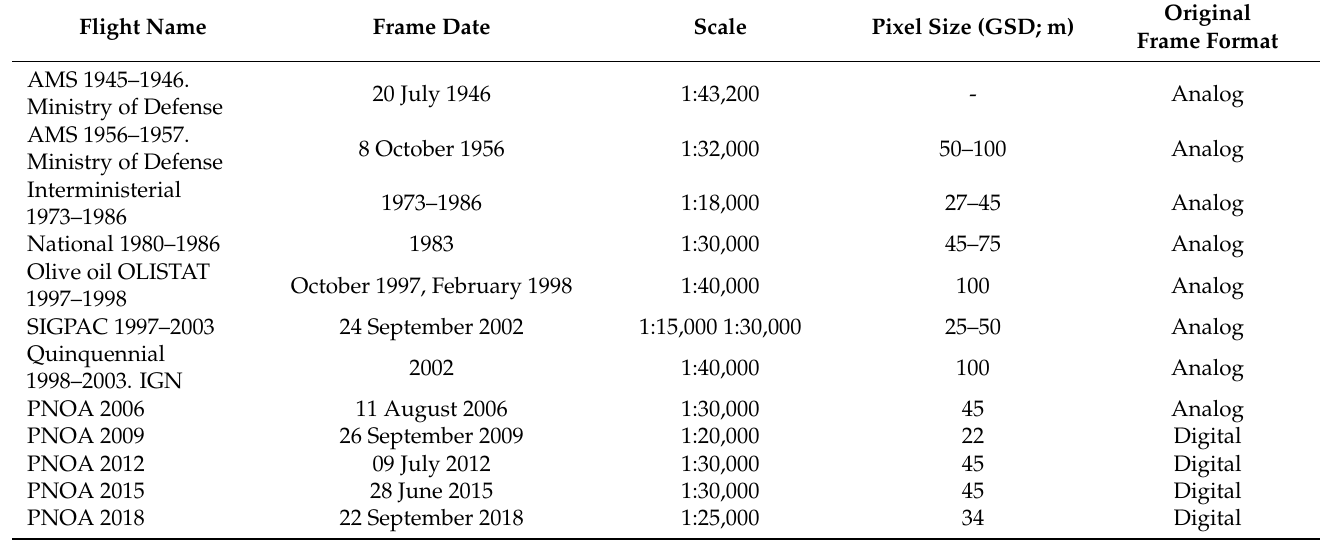
Table 1. Characteristics of the aerial imagery used in the study. AMS, American Army Map